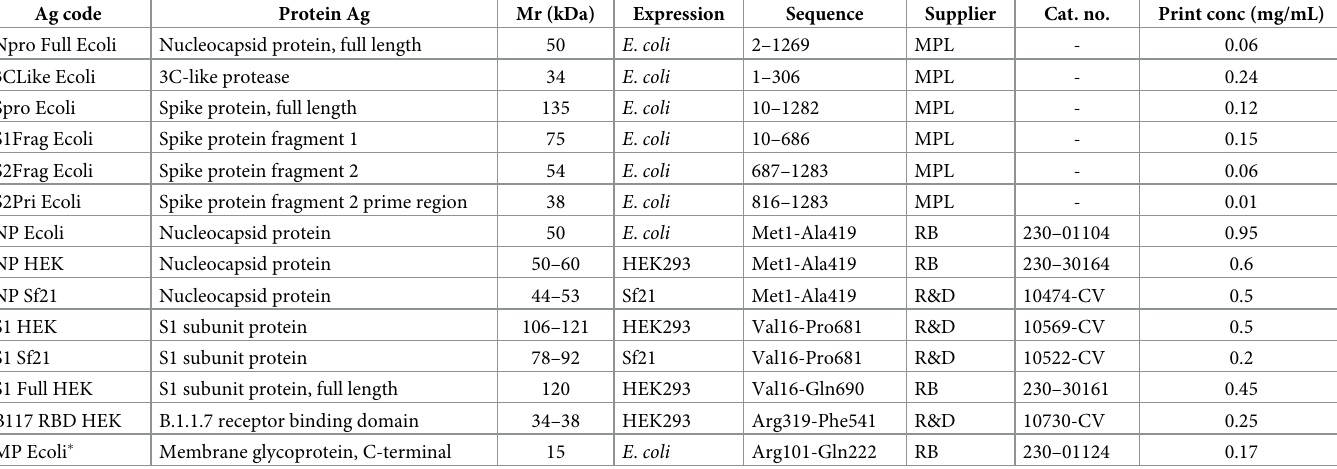
Table 1. Recombinant SARS-CoV-2 proteins used to construct the antigen (Ag) microarray, the Ag code, molecular mass (Mr) observed by SDS-PAGE, expression system, protein sequence expressed, supplier, catalogue number, and approximate print concentration (mg/mL). MPL, Molecular Parasitology Lab; RB, RayBiotech; R&D, R&D Systems. � Ag failed to conjugate and omitted from